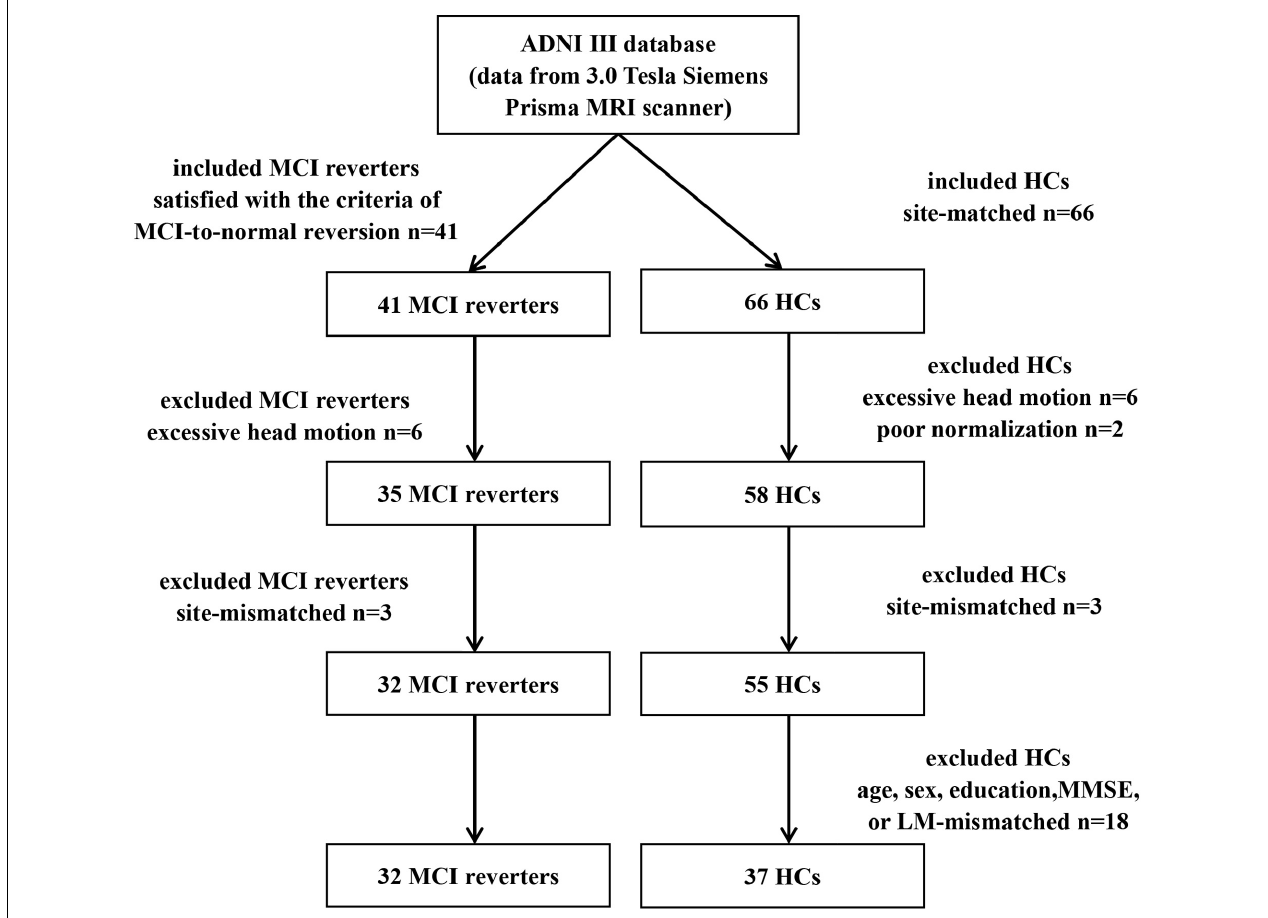
FIGURE 1 | The process of including subjects. HCs, healthy controls; MCI, mild cognitive impairment; n,